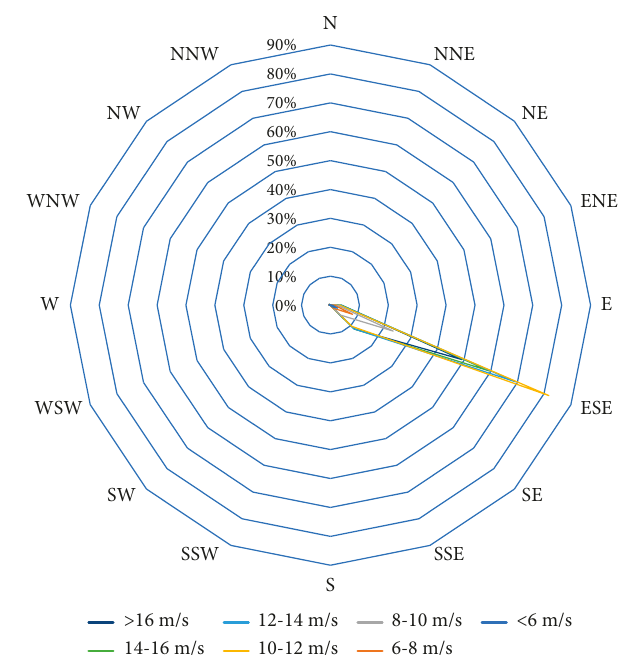
Figure 8: A wind rose for LTWPP